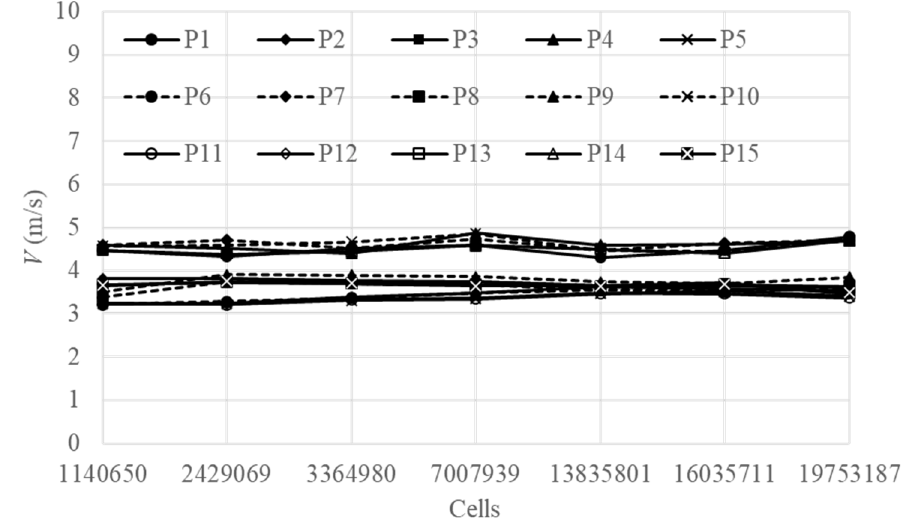
Figure 9. Grid independence of CFD Model.